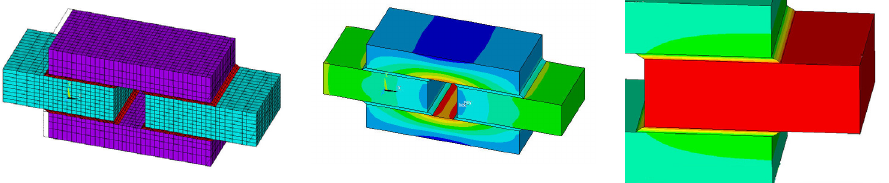
Figure 8a, b and c: Numerical model of tested shear